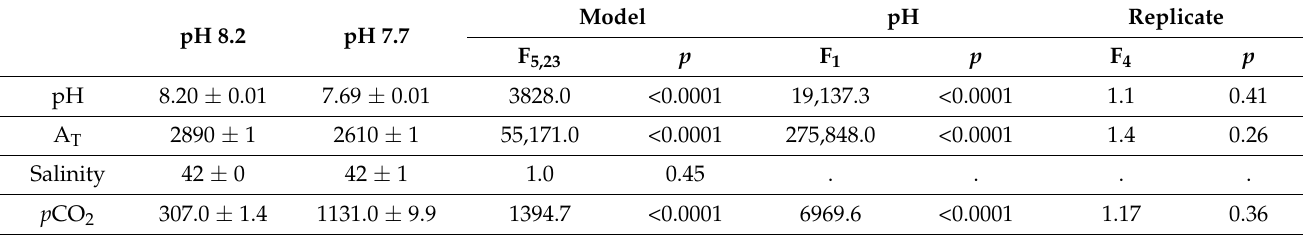
Table 2. Summary of the carbonate chemistry: measured pH on the total scale, alkalinity (A T in µ mol/kg), salinity (in ‰), and calculated p CO µ atm). Difference between target the two target 2 (in pHs and between replicates was tested using an ANOVA 2. Results are presented as mean ± SEM. pH